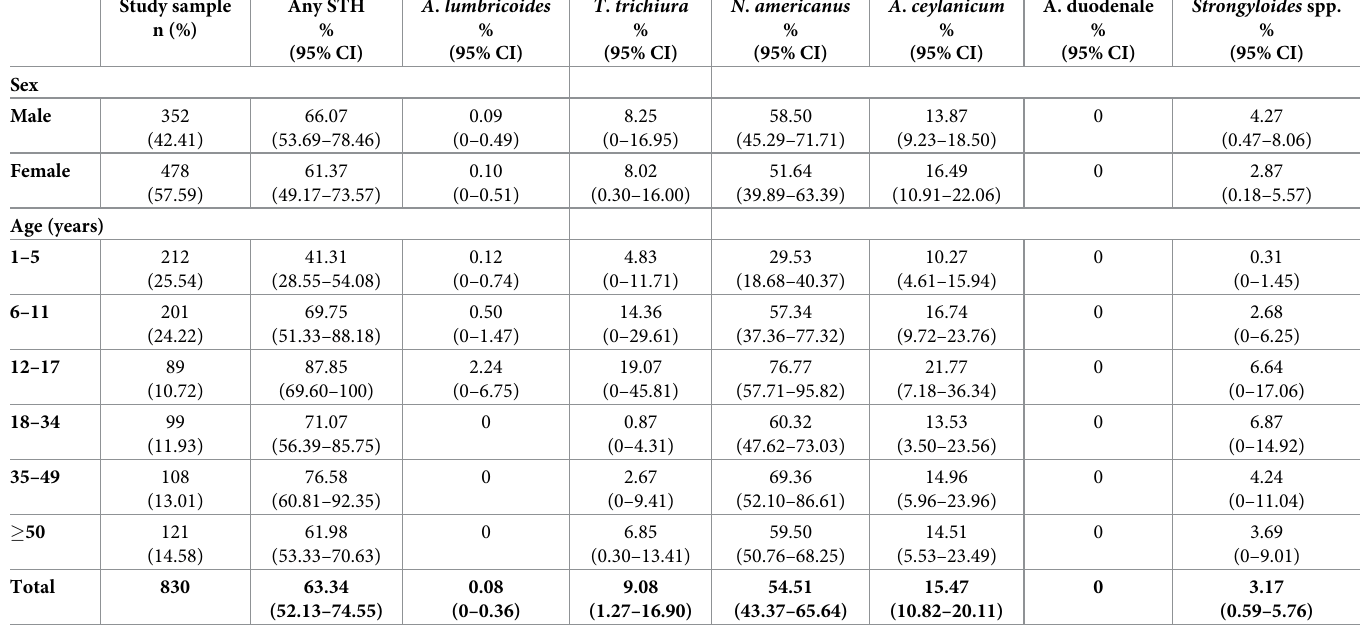
Table 2. Cluster-adjusted STH prevalence by species, stratified by sex and age group. Study sample n